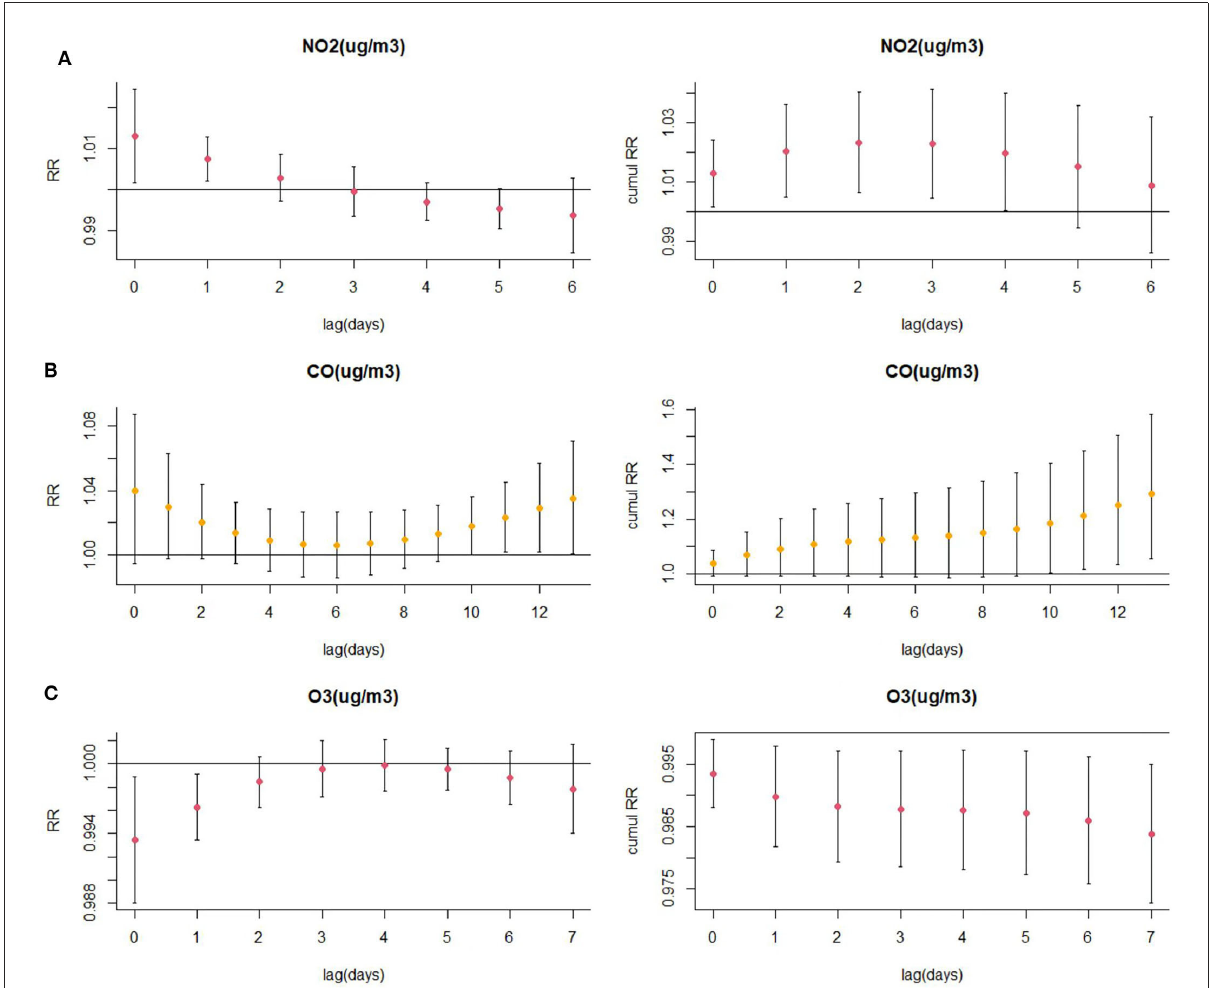
FIGURE5 (A) Lagged specific relative risk (%) and (B, C) cumulative risk (%) of CHD hospitalization for each 10 (or 1) unit increase in daily average air pollution concentration in the model.